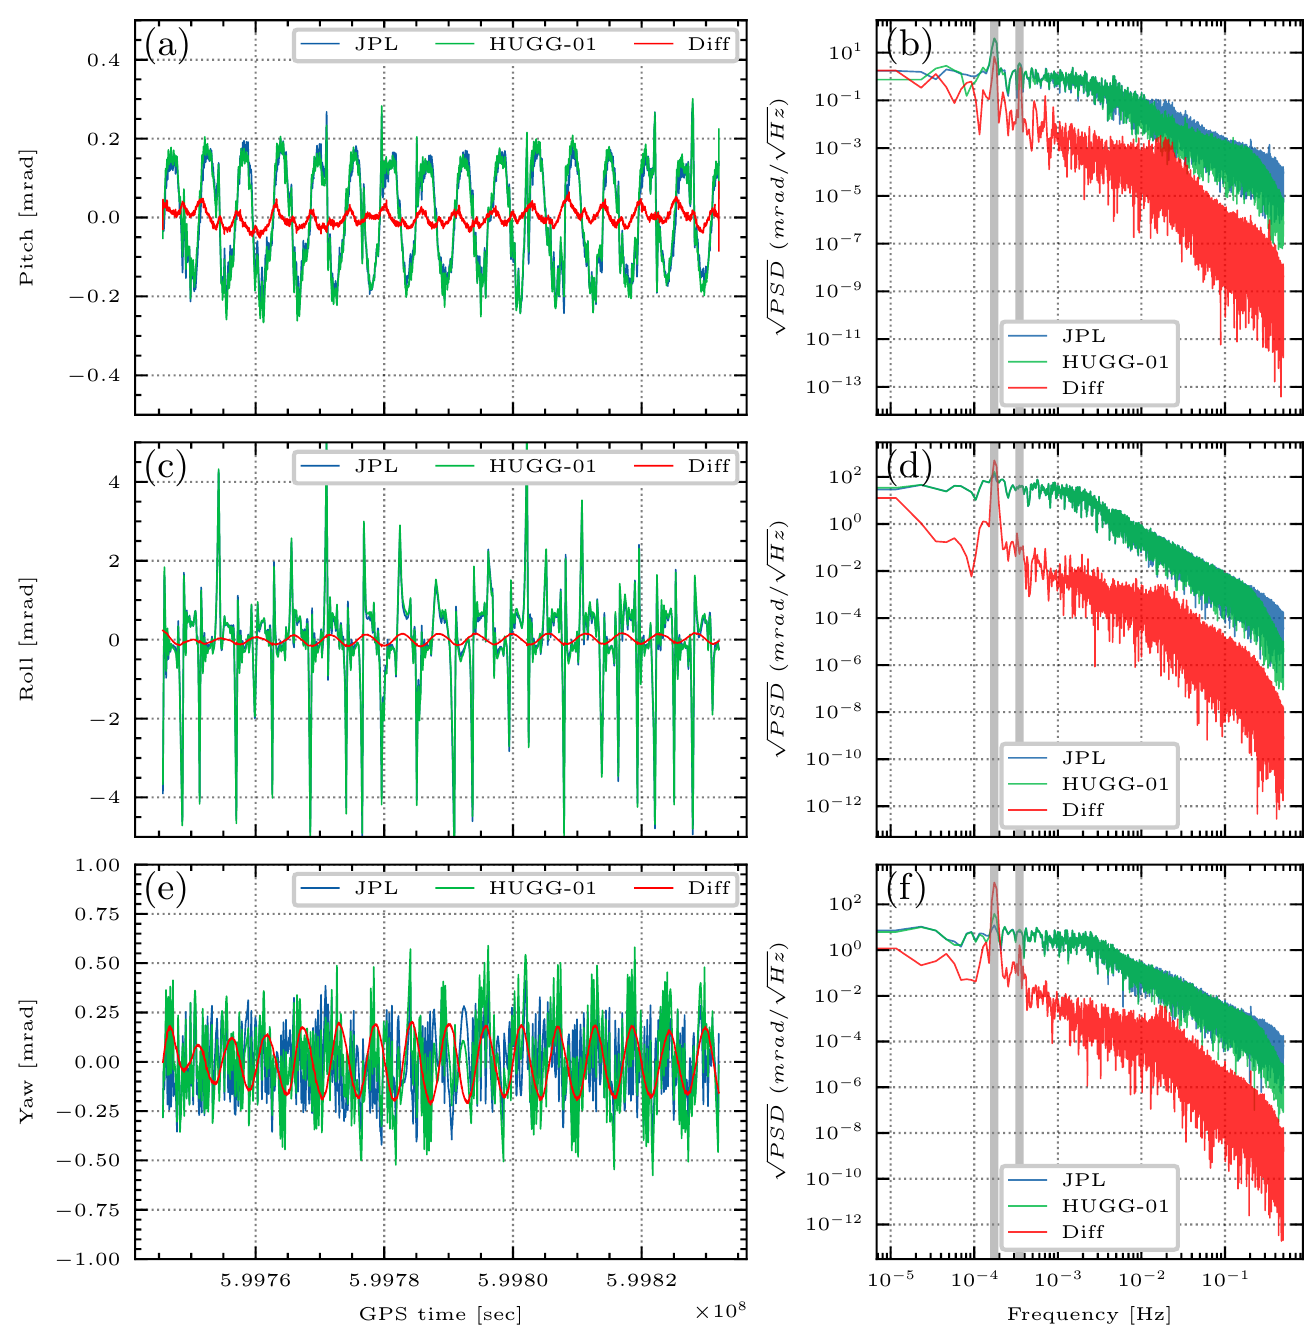
Figure 8. Comparisons between JPL and HUGG-01 in terms of pointing variations on 3 January 2019 for Sat-D. The pointing variations are expressed in terms of pitch ( a , b ), roll ( c , d ) and yaw ( e , f ) angles with their mean subtracted. From left to right, the first grey vertical line of ( b , d , f ) denotes the one-CPR frequency that corresponds to 1.6 h, and the second one denotes the two-CPR frequency that corresponds to 0.8